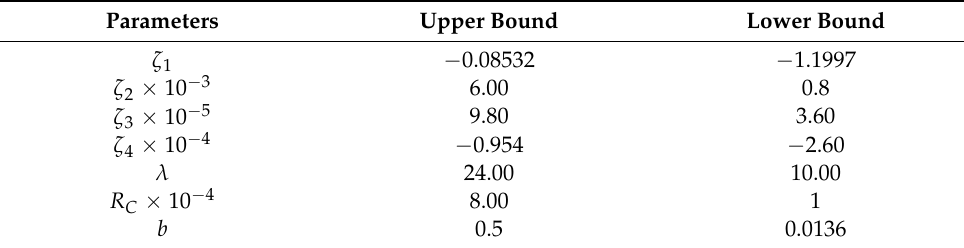
Table 4. Lower and upper bounds of parameters for PEMFC.